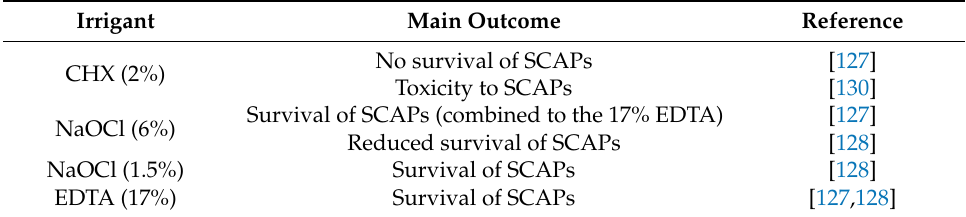
Table 4. Surface hardness of tooth-colored restorative materials and tooth hard